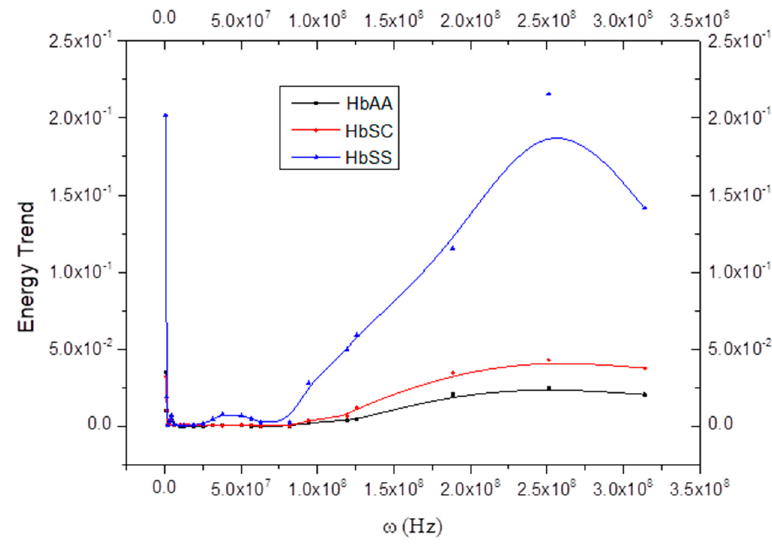
Figure 6. Comparison between HbAA (black line), HbSC (red line) and HbSS (blue line) Energy trend calculated by Equation (54), as a function of frequency.